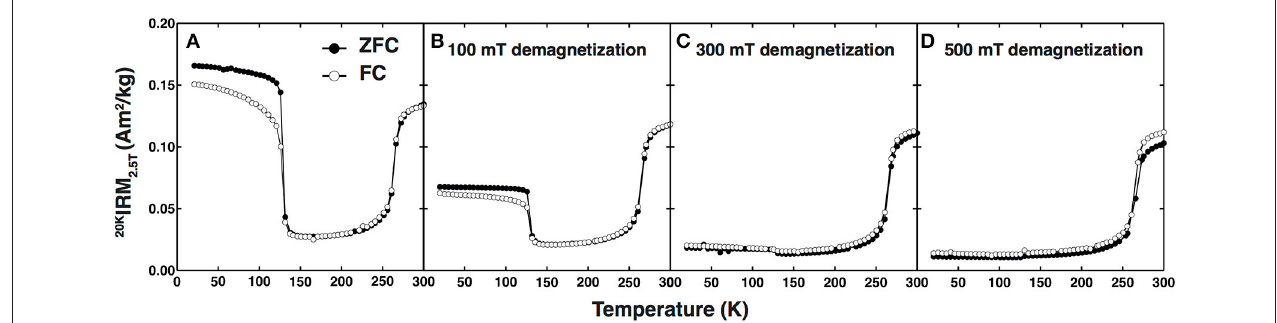
FIGURE 6 | (A) ZFC and FC warming curves of a commercially available hematite purchased from The Nature Company, which also contains magnetite. The same sample was subjected to a new ZFC-FC acquisition where the ZFC and FC 2.5 T IRMs acquired at 20K were partially demagnetized by charging the supraconducting magnet in the no-overshoot mode to 100 mT (B) , 300 mT (C) , or 500 mT (D) and further to zero in the oscillation mode. MPMS sequence is provided in Supplementary Material.